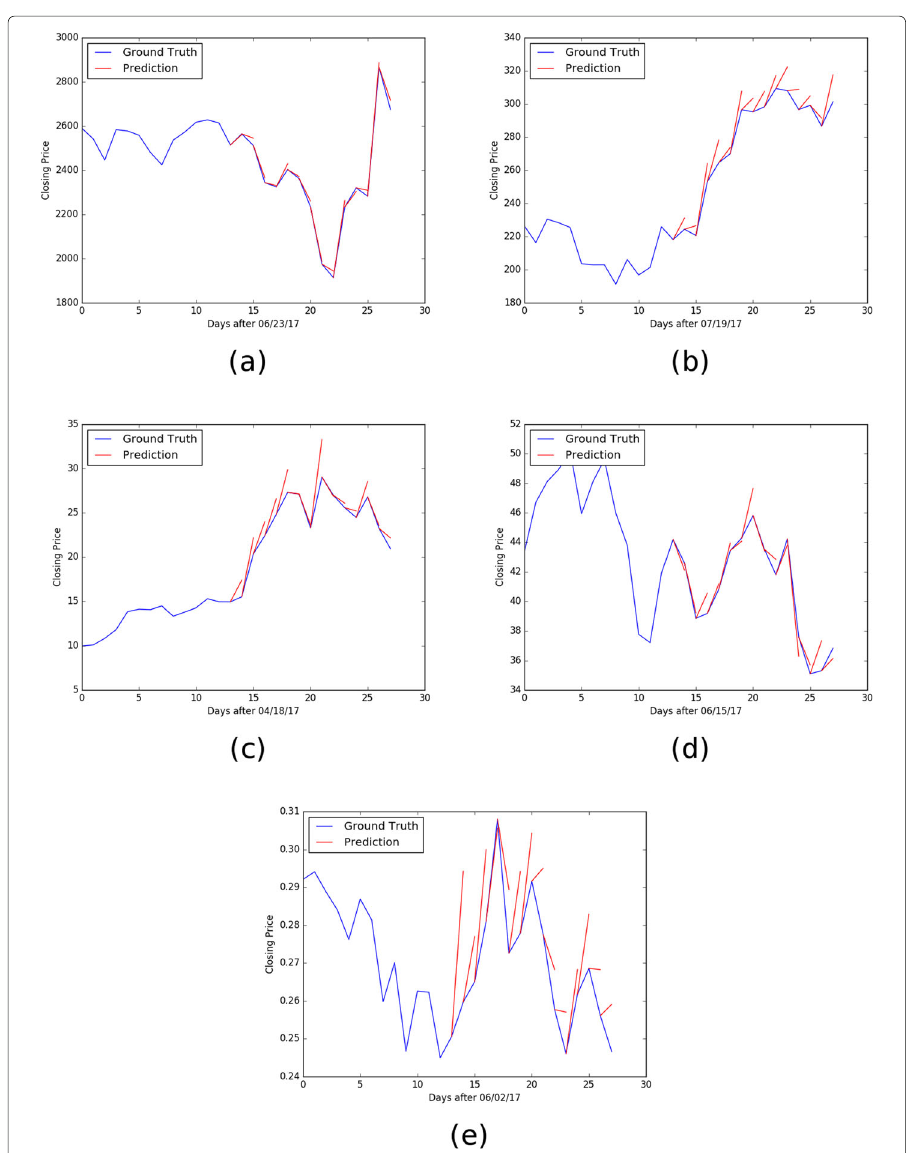
Fig. 7 The ground truth for ( a ) Bitcoin, ( b ) Ethereum, ( c ) Litecoin, ( d ) Monero, and ( e ) XRP is compared against the prediction. Each prediction is based off of the previous known data point and each individual line is a separate prediction. This best shows for each prediction whether the closing price is predicted to increase or decrease. The number of positive identifications can be seen in Table